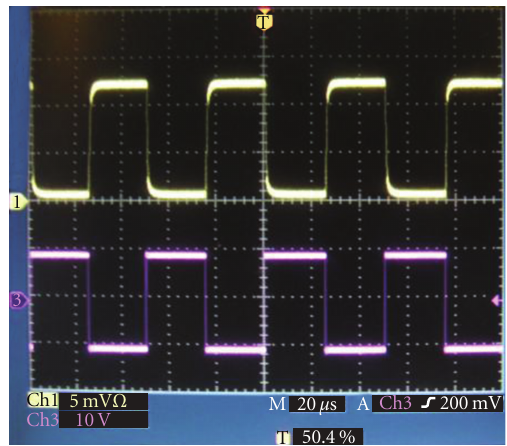
Figure 3: 1.5- μ m optical output signal after polarizer with the angular di ff erence between the transmitter and receiver of 0 ◦ ≤ | Δ θ | < 45 ◦ . (a) The 1.5- μ m optical output signal after the polarizer and (b) the applied voltage (20:1) for the polarization modulator are shown as Ch1 and Ch3 with the modulated frequency of 20kHz.